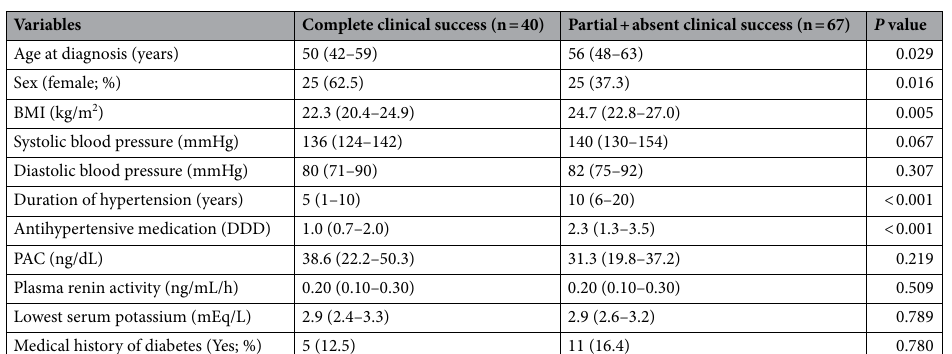
Figure 1. Flow chart.